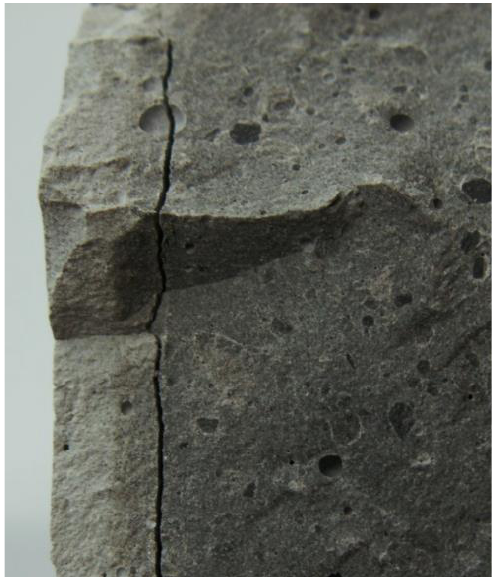
Figure 6. Fracture with a visible crack at the border of altered zone at a depth of 5.5 – 6.0 mm: B-25 specimen.